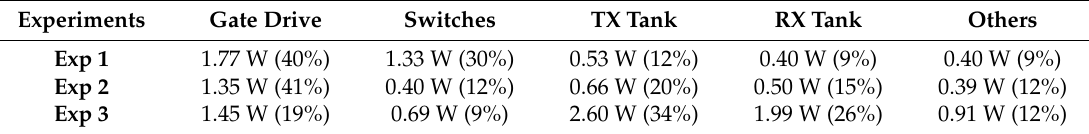
Table 4. Power losses and the corresponding percentage of each block in Exp 1, Exp 2, and Exp 3.